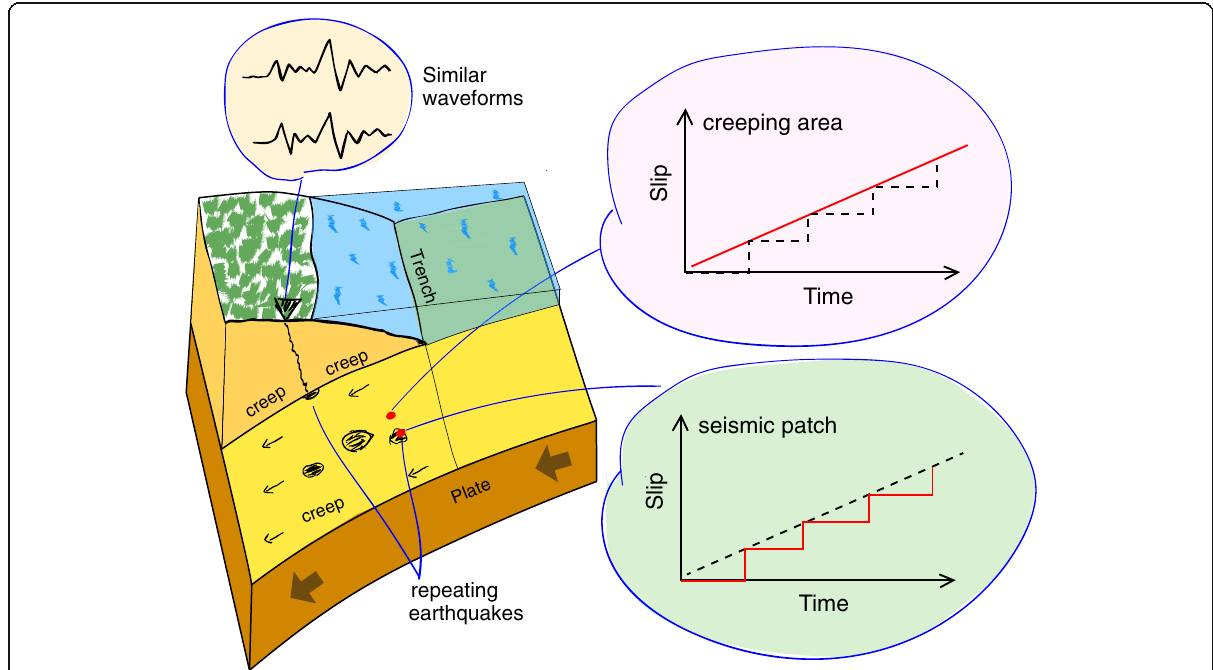
Fig. 1 Schematic model of the environment where repeating earthquakes occur in a subduction zone. The repeating earthquakes occur on a seismic patch (black spots) in the creeping area of the plate boundary. They produce similar waveforms when observed by the same station (left top) because the seismic patch is loaded by creep in the surrounding area and repeat rupture at the same place. The creeping area (slip shown in red in the right top panel) and repeating earthquake patch (slip shown in red in the right bottom panel) undergo almost the same long-term cumulative slip because they are located on neighboring plate boundaries. The dashed line shows slip at neighboring area (seismic patch for creeping area and vice versa). Please note the patch for the repeating earthquake may have slip in the interseismic period (Beeler et al. 2001) but the relationship between the slip at the creeping area and the slip at patch for repeating earthquakes holds in that case